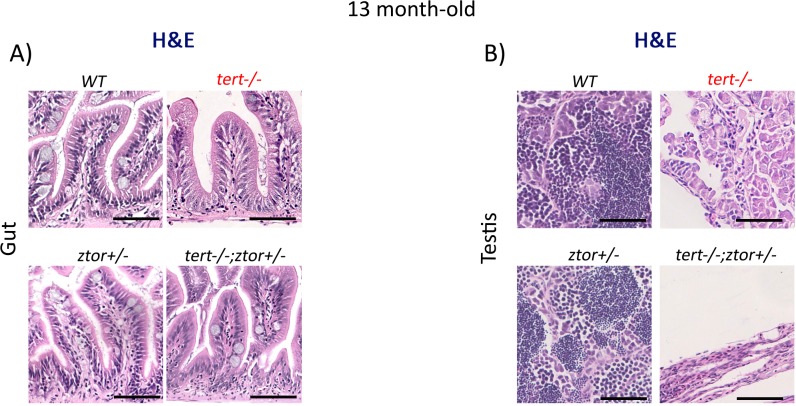
ztor haploinsufficiency is not sufficient to suppress tissue defects in tert-/- zebrafish.The absence of one copy of the ztor gene is not sufficient to rescue the morphological defects observed in the tert-/- at 13 months of age. (A and B) Representative haematoxylin and eosin-stained sections of gut (scale bar = 40 µm) (A) and testis (scale bar = 25 µm) (B) from 13-month-old WT, tert-/-, ztor+/- and tert-/- ztor +/- siblings (N = 3 fish each).